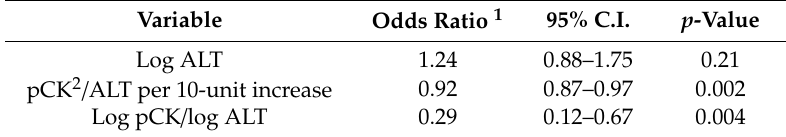
Table 6. Logistic regression of inpatient mortality on alanine aminotransferase (ALT) variables ( n =